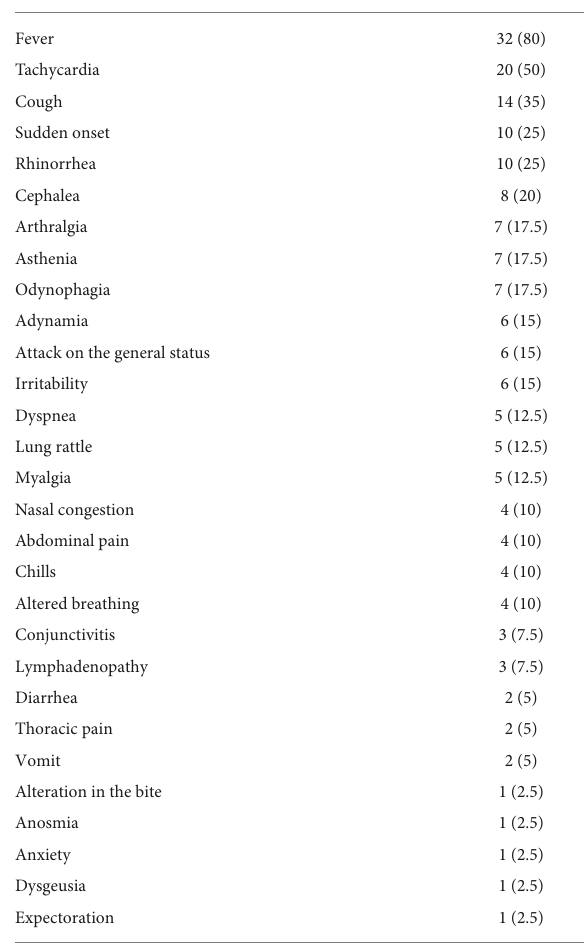
TABLE 2 Frequency of clinical manifestations in children with cancer and